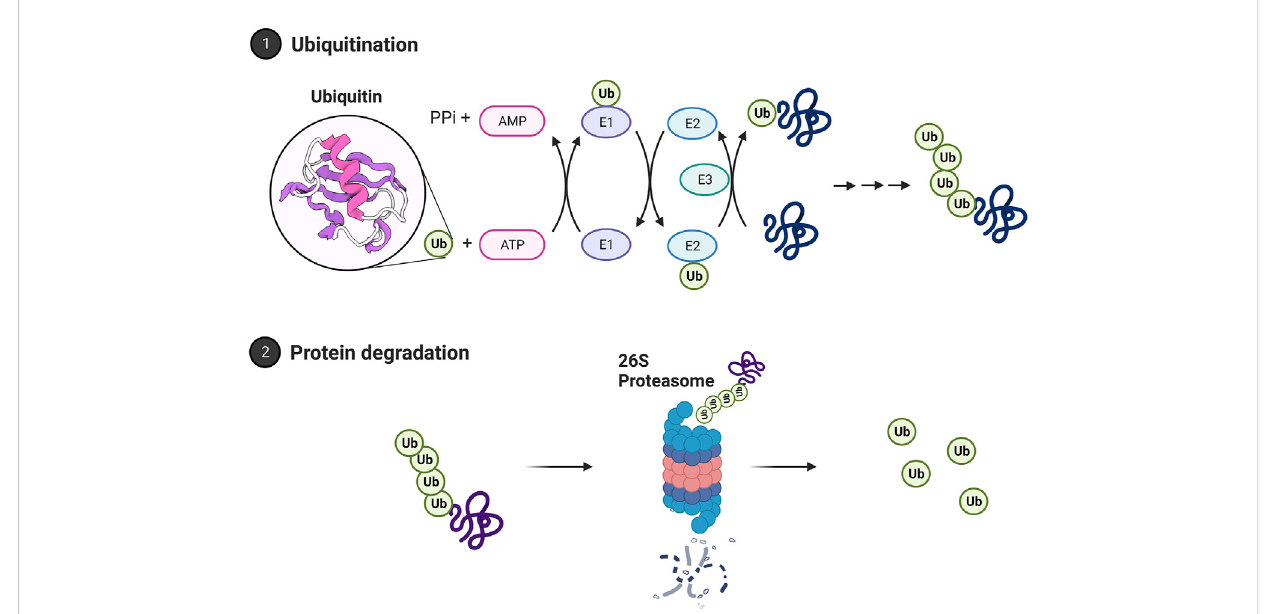
FIGURE 3 The ubiquitin proteasome system. Proteins are polyubiquitinated in a process relying on E1, E2, and E3 ubiquitin ligases. Ubiquitin is bound to the E1 activating enzyme in an ATP-dependent process. The E1 ubiquitin activating enzyme will bind to and transfer ubiquitin to an E2 ubiquitin conjugating enzyme. An E3 ubiquitin ligase will then bind both the ubiquitinated E2 enzyme and the protein target, facilitating the transfer of ubiquitin to the target protein. A chain of ubiquitin residues can form on a target protein through this approach. A chain of at least 4 ubiquitin residues may be targeted to the 26S proteasome for degradation. The polyubiquitin chain is bound by the 19S regulatory cap and the protein fed into the core for degradation. Ubiquitin is then recycled by deubiquitinating enzymes. Images Created with